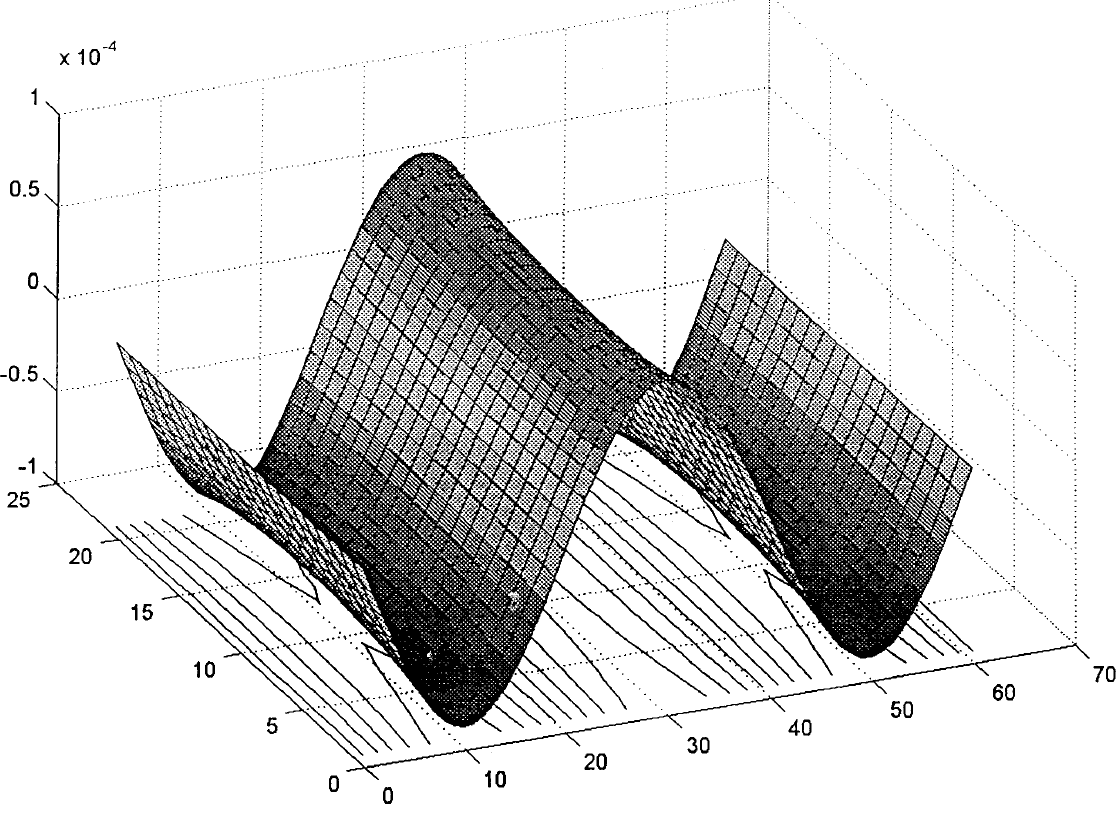
Fig. 6. First mode shape of 3-span deck, φ 1 = φ 3 = 1 . 0 , φ 2 = 1 . 1 . Table 1 Computed first mode eigenvalue, λ 2 vs. K , number of terms